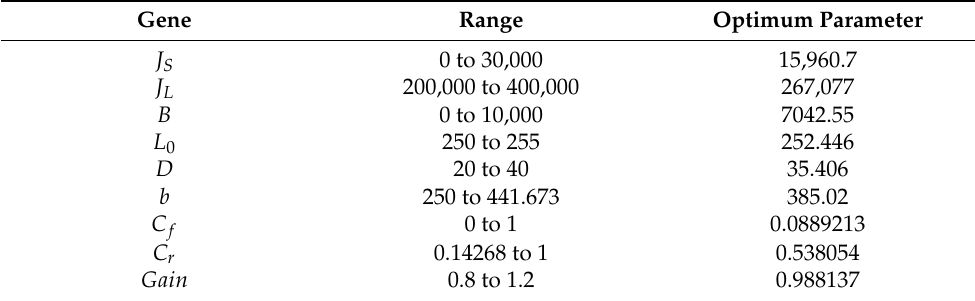
Table 4. Range of parameter configuration of a dynamic model of a robot arm and optimal parameter. Gene